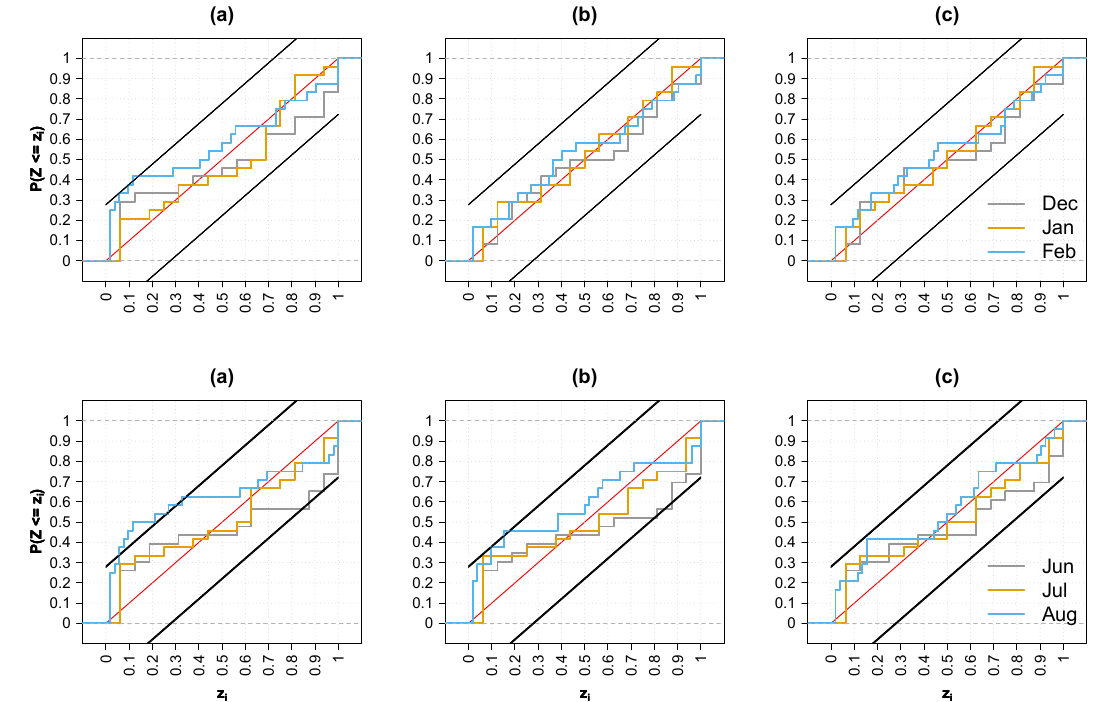
Figure 8. PIT diagrams of daily monthly mean streamflow post-processed forecasts for summer (upper row) and winter (bottom row) of station 82. Streamflow forecasts are post-processed using the quantile mapping (QM) method for predictions generated using raw (a) and preprocessed forcings with the linear scaling/delta change (b) and quantile mapping (c) methods. Lead time 1 month. The black lines parallel to the 1:1 diagonal are the Kolmogorov bands at the 5% significance